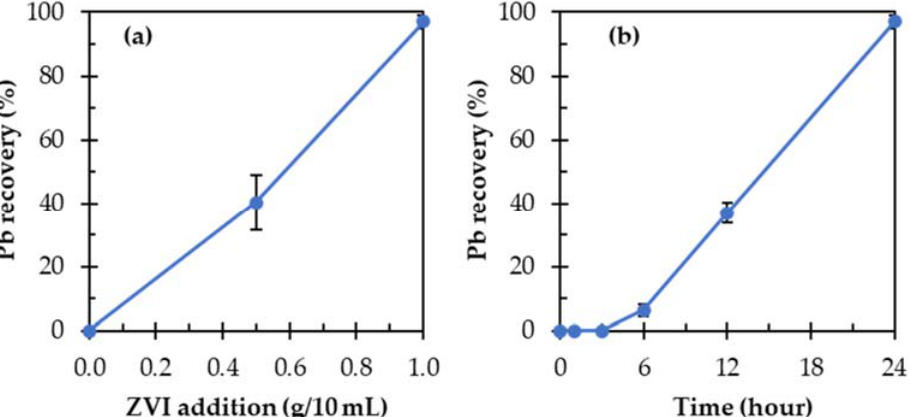
Figure 5. ( a ) Effects of the ZVI amount on the recovery of the extracted Pb after 24 h in the leachate after PbSO 4 extraction using 500 mM of EDTA for 30 min and ( b ) effects of time on the recovery of the extracted Pb 2+ using 1 g/10 mL of ZVI in the leachate after EDTA pretreatment using 500 mM EDTA for 30 min.